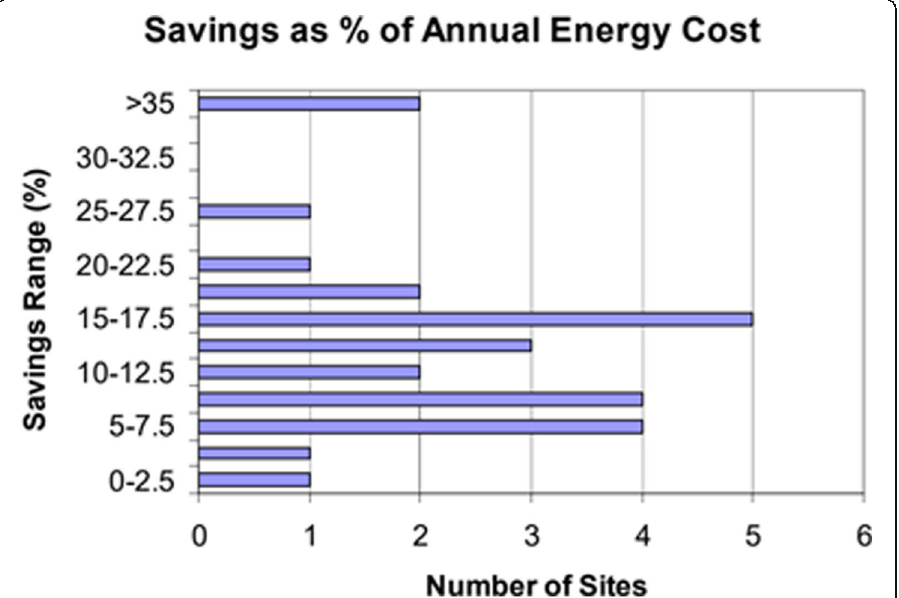
Fig. 4 Energy costs savings in 26 non-residential buildings with continuous commissioning implemented (Bynum et al.,